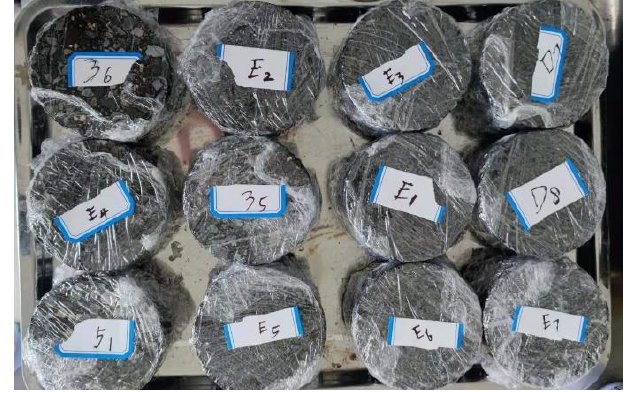
Figure 2. The photos of the samples before testing.